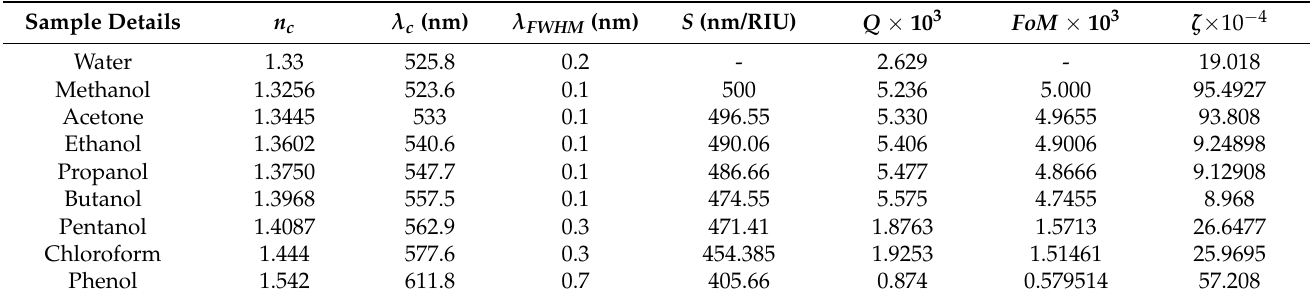
Table 6. Bio-alcohol sensor performance with d c = 230 nm corresponding to θ = 80 ◦